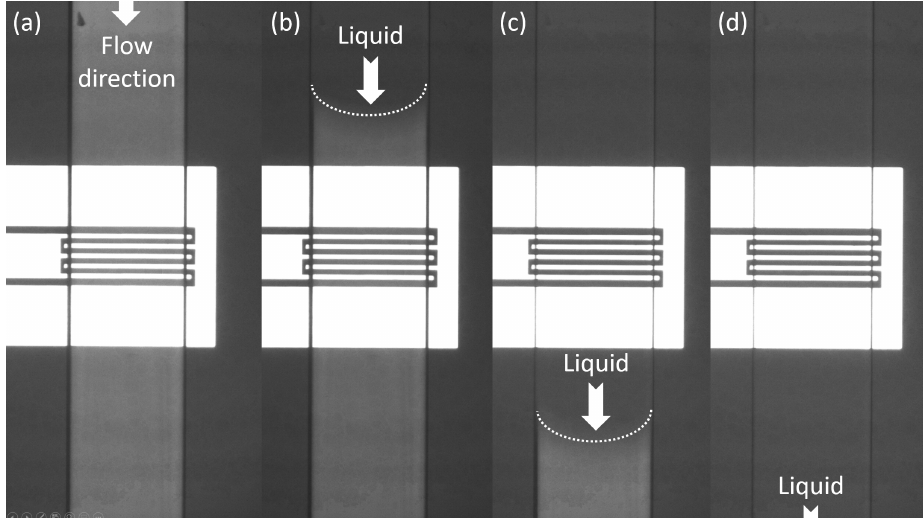
Figure 5. Microscope photograph of the fluidic channel filled by DI water with a flow from top to bottom: ( a ) eEmpty channel; ( b ) partially filled channel; ( c ) partially filled channel; and ( d ) filled channel.